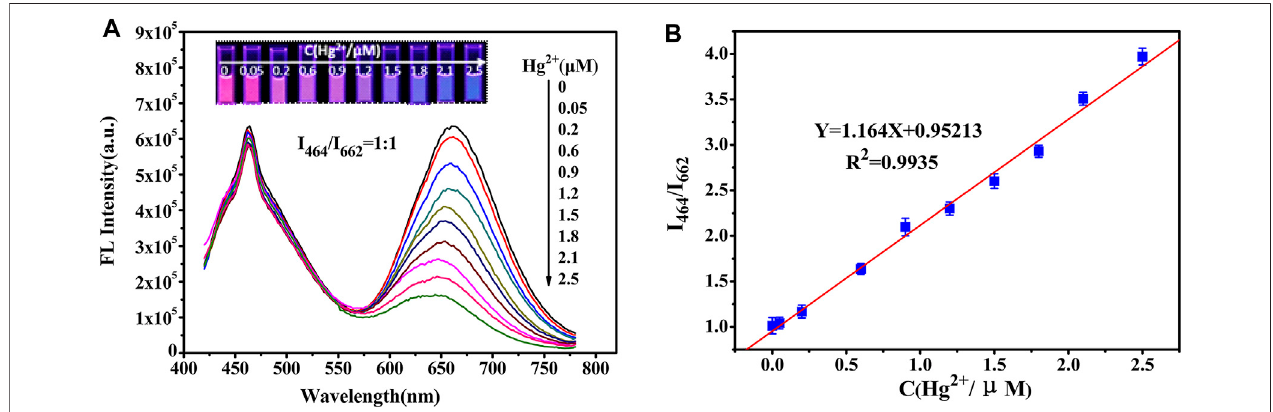
FIGURE 2 | (A) Fluorescence spectra of the ratiometric fl uorescent probes with the addition of Hg 2+ . The ratio of fl uorescence intensity of NCDs to Au NCs is 1:1. The inset shows the corresponding fl uorescence photographs taken under a 365 nm UV lamp. (B) Linear plot of the ratio of I 464 /I 662 versus Hg 2+